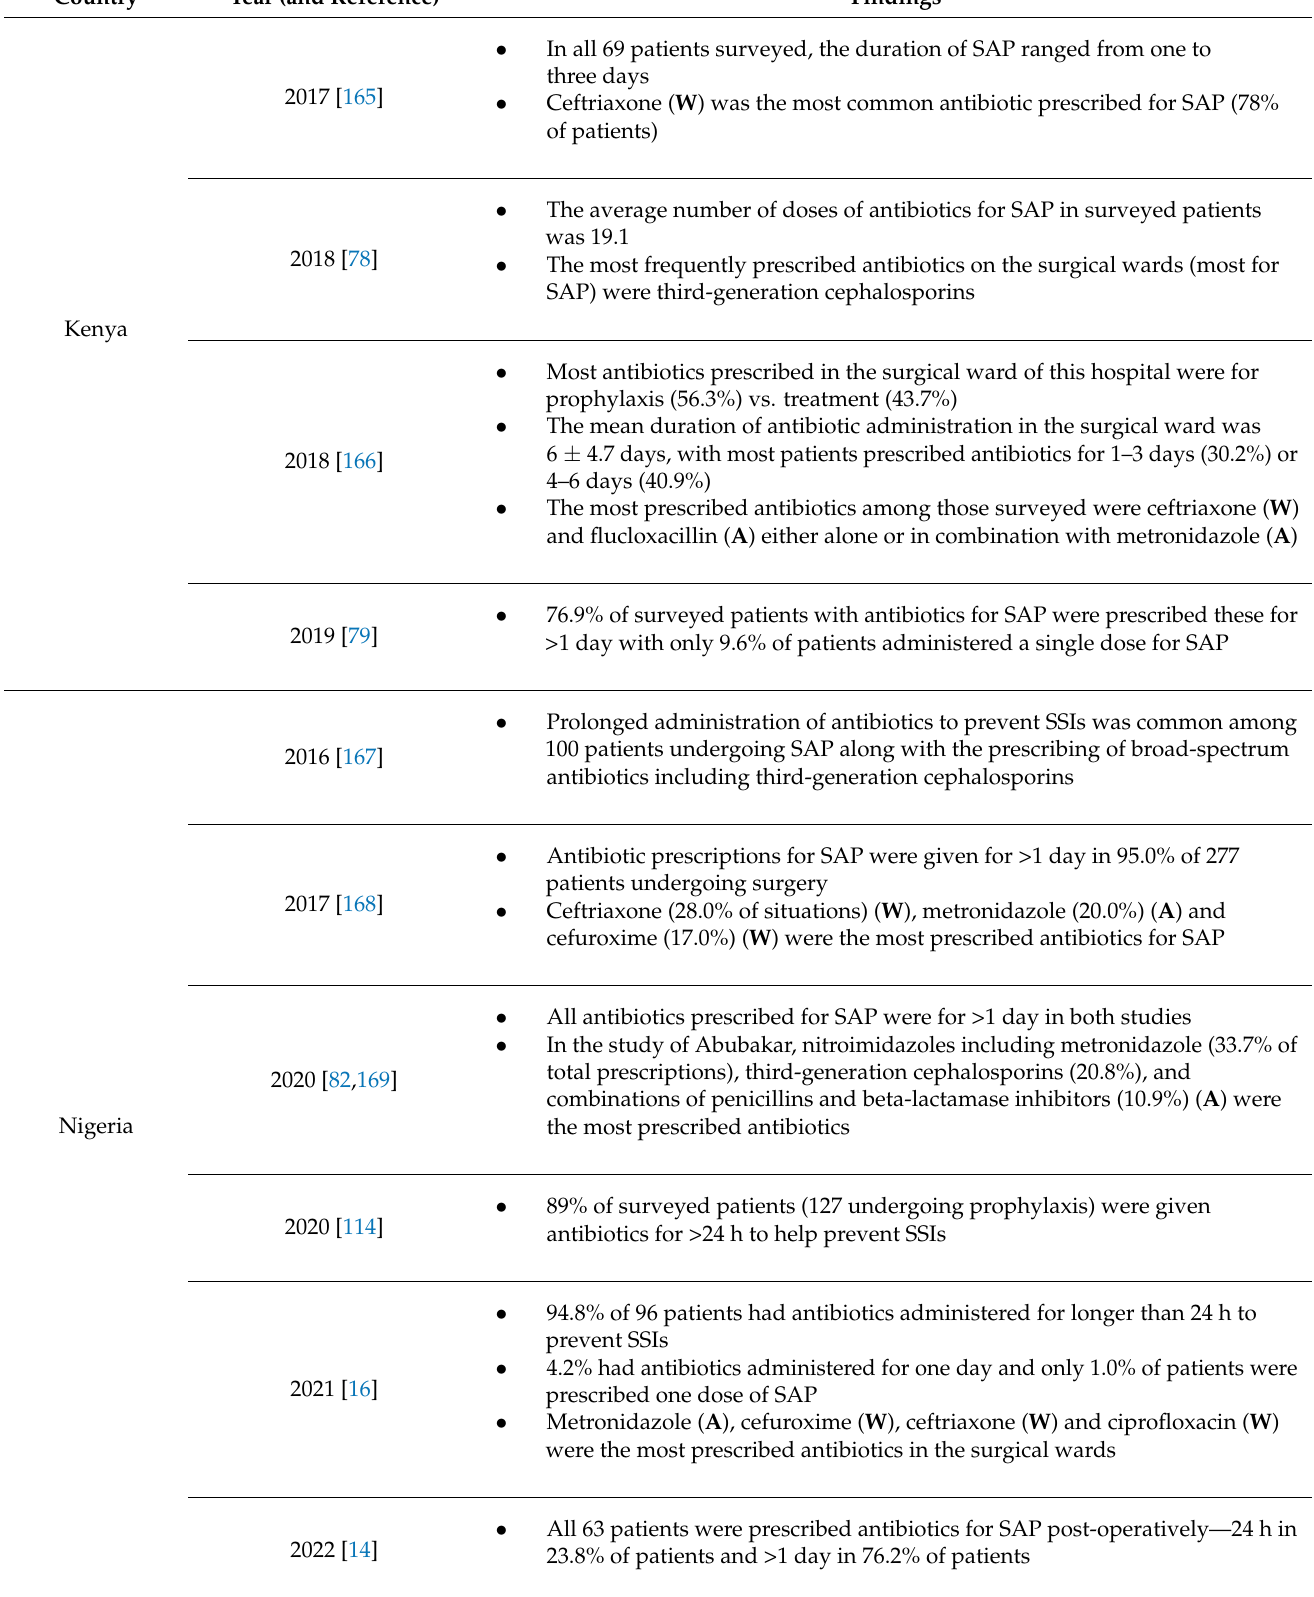
Table 1. Cont. Country